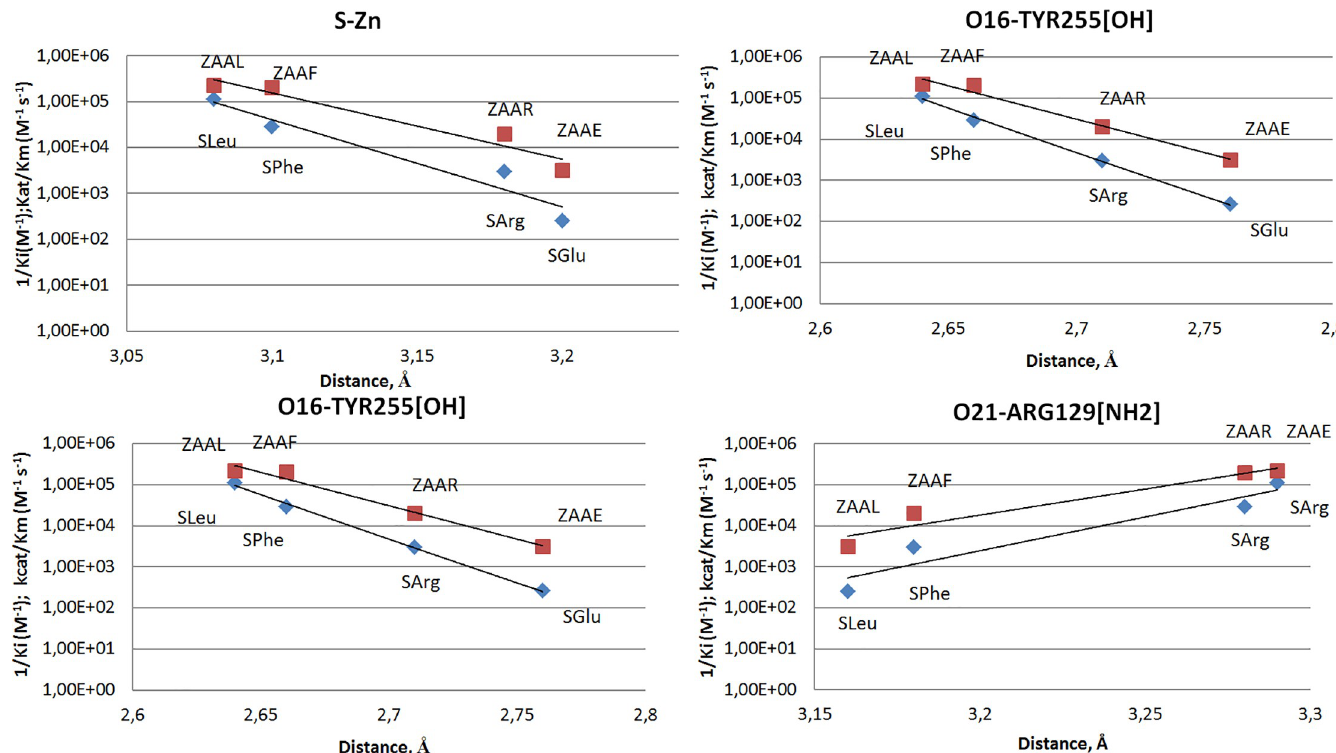
Fig 2. The inhibition of CPT and its catalytic efficiency depend on the gap between the inhibitor and the residues of the enzyme’s catalytic center. Association constants (1/K I ) of the transition state analogs are shown as blue diamonds, catalytic efficiencies (k cat /K M ) on the corresponding substrates are shown as red squares.